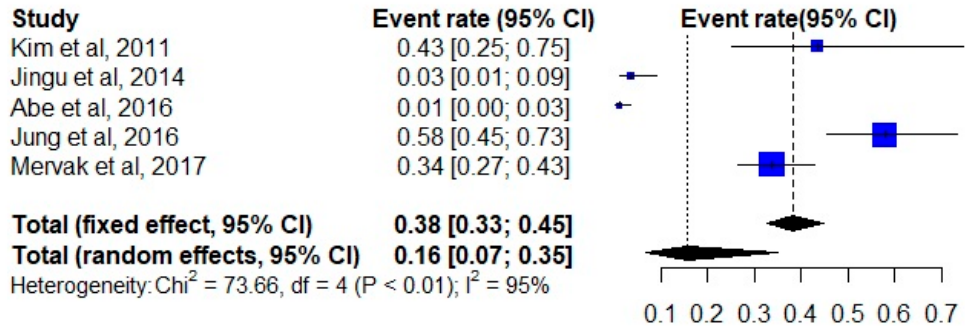
Figure 2. Forest plot of the initial event rate of hypersensitivity reactions in all included studies. [29,26,30,28,27].